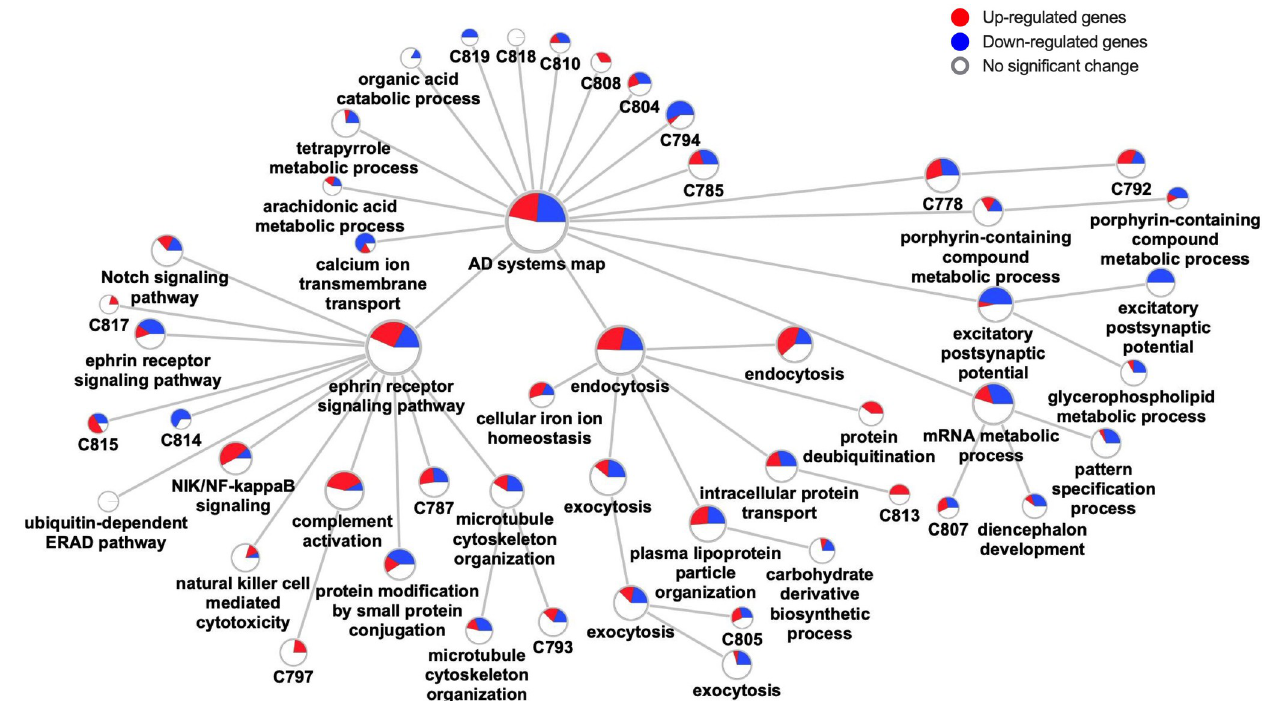
Fig 4. Hierarchical graph of the AD gene network. Pie charts indicate fractions of up- (red) and down- (blue) regulated genes.